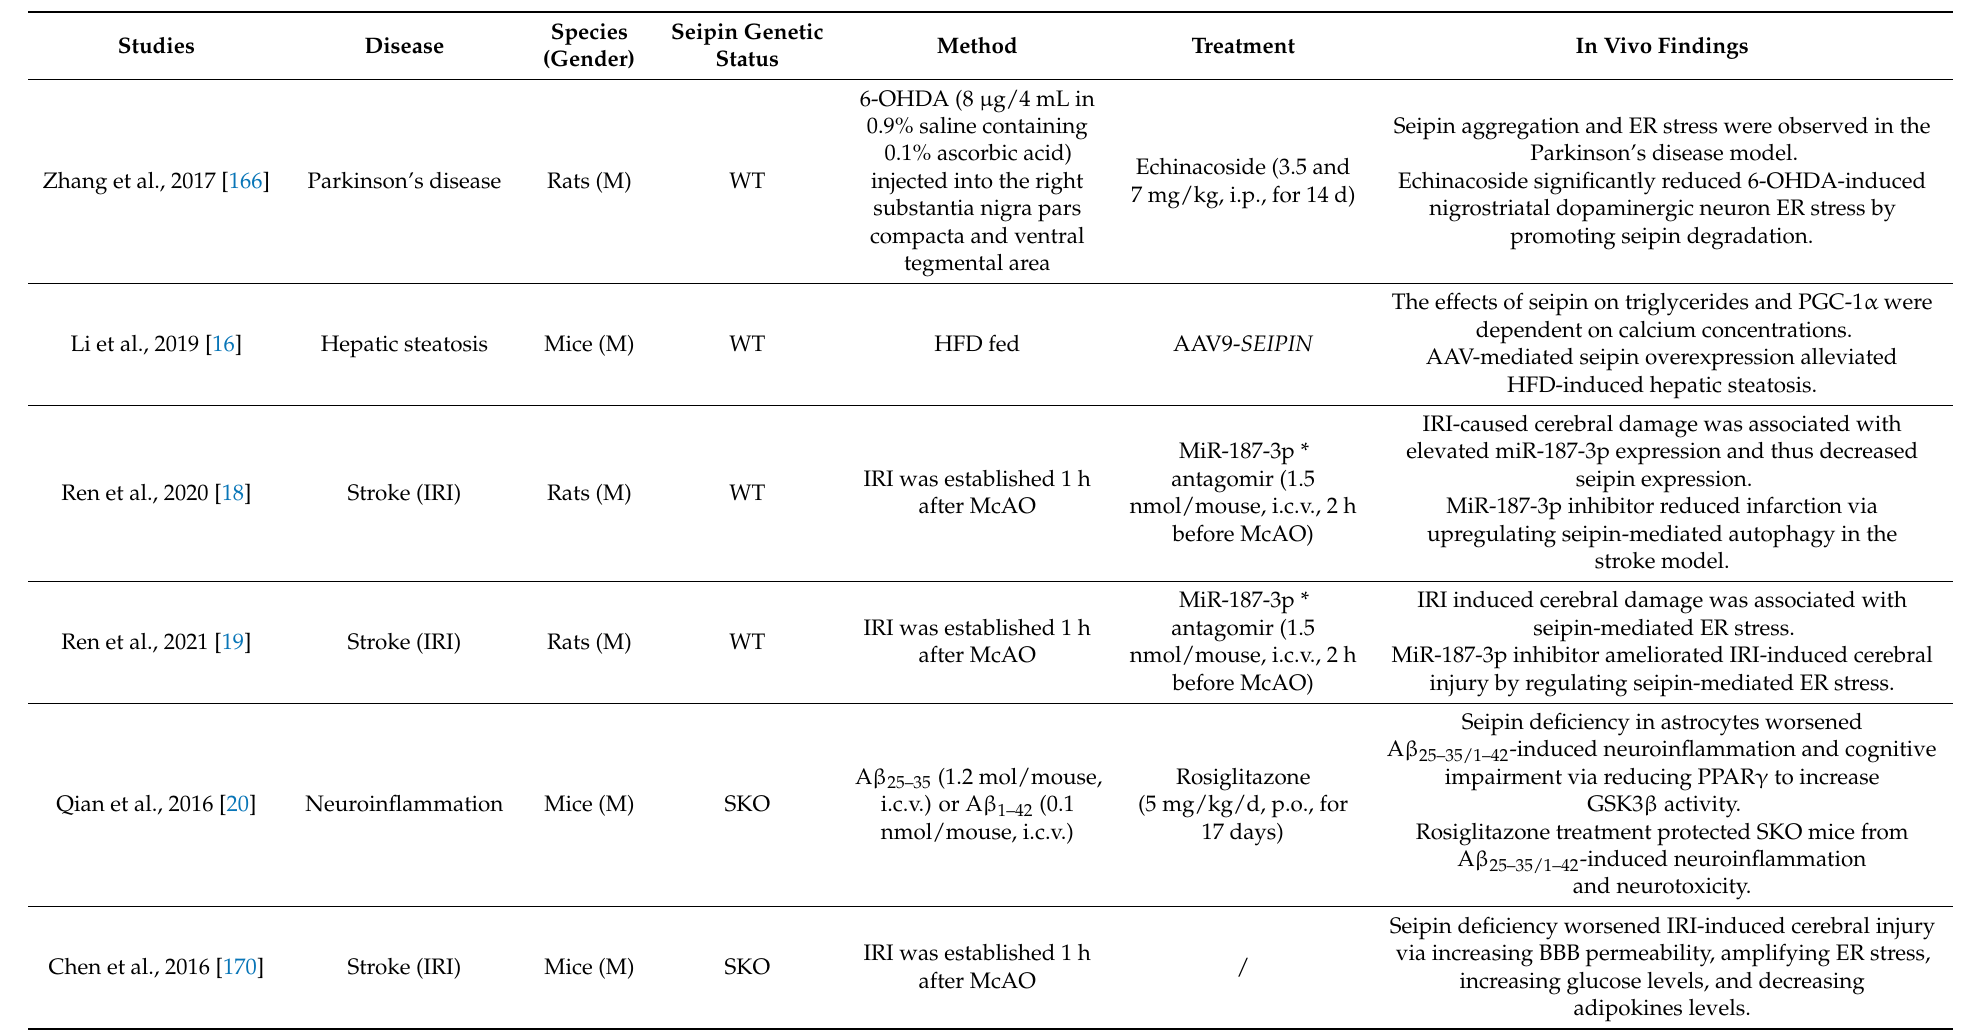
Table 7. The role of seipin in rodent disease